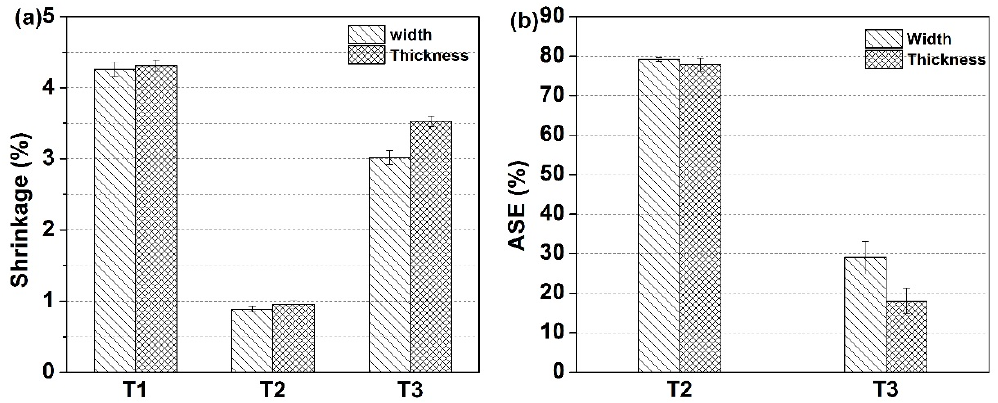
Figure 6. Final shrinkage rates ( a ) and anti-swelling efficiencies (ASEs) ( b ) of T1, T2, and T3.